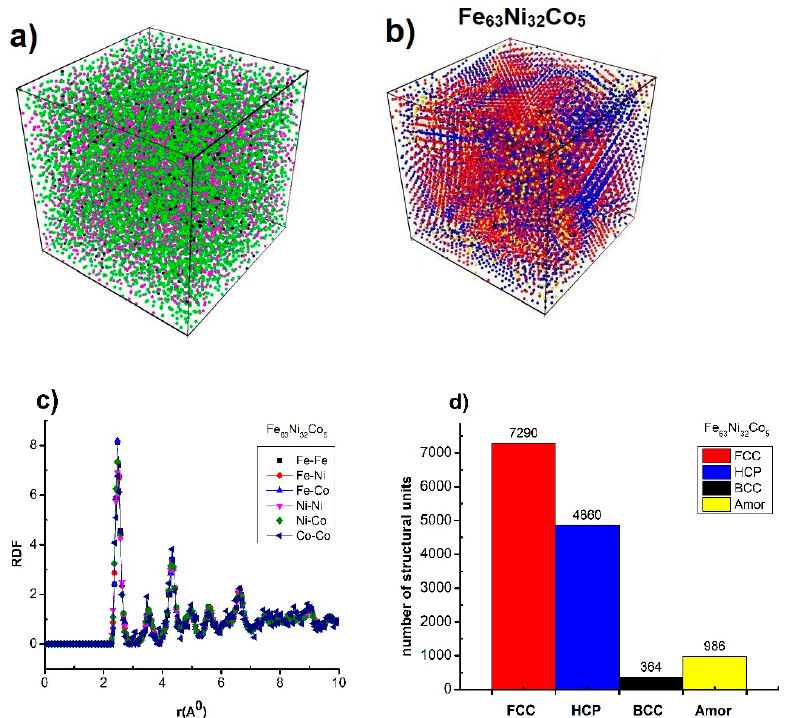
Figure 1. Shape ( a ), structure shape ( b ), RDF ( c ), number of structural unit ( d ) of Fe 63 Ni 32 Co 5 alloy at T = 300